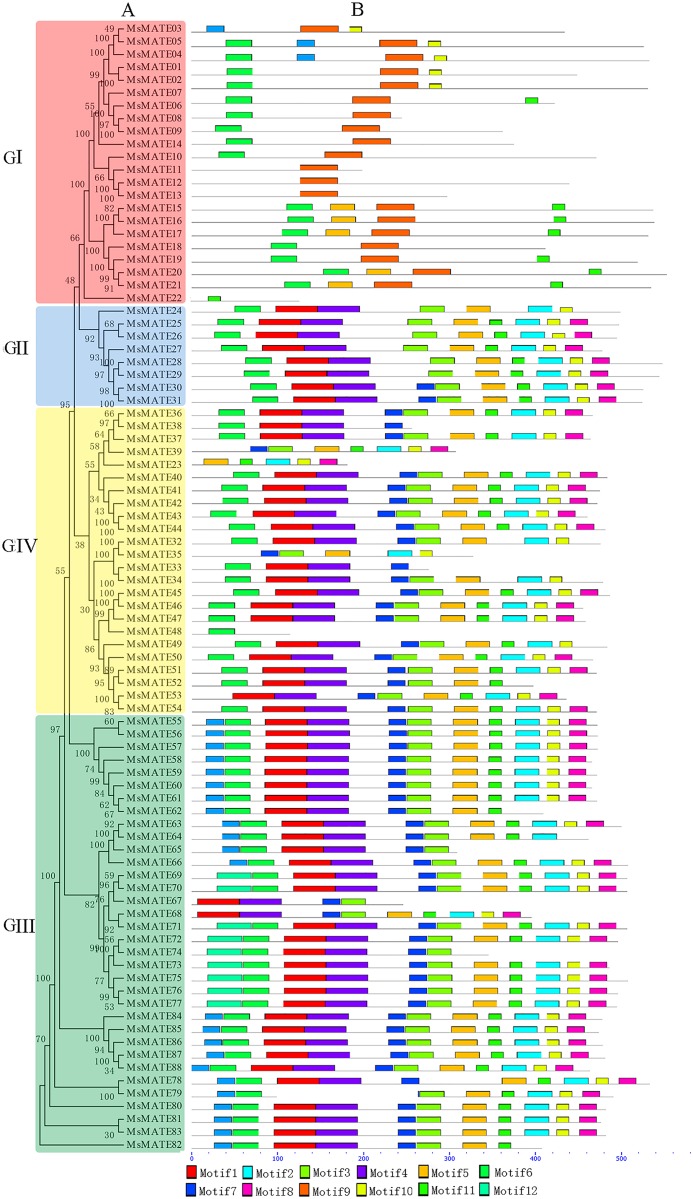
Phylogenetic relationships and domain compositions of the MsMATE proteins.(A) The unrooted phylogenetic tree was constructed with 1,000 bootstrap replicates based on a multiple alignment of 88 MATE genes amino acid sequences. The four major subgroups are marked with different-coloured backgrounds. (B) The conserved motifs in the MsMATE proteins were identified using MEME. Grey lines represent the non-conserved sequences. Each motif is indicated by a coloured box numbered at the bottom. The length of the motifs in each protein is exhibited proportionally.